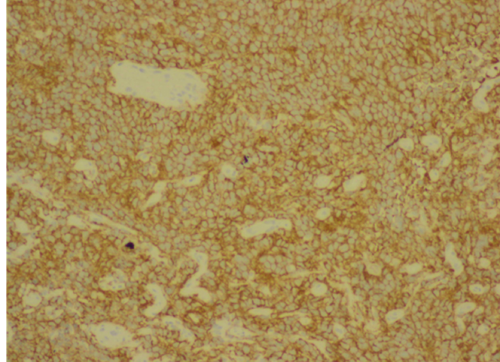
Figure 3: Uniform, strong CD20 positivity of the neoplastic cells (20x).